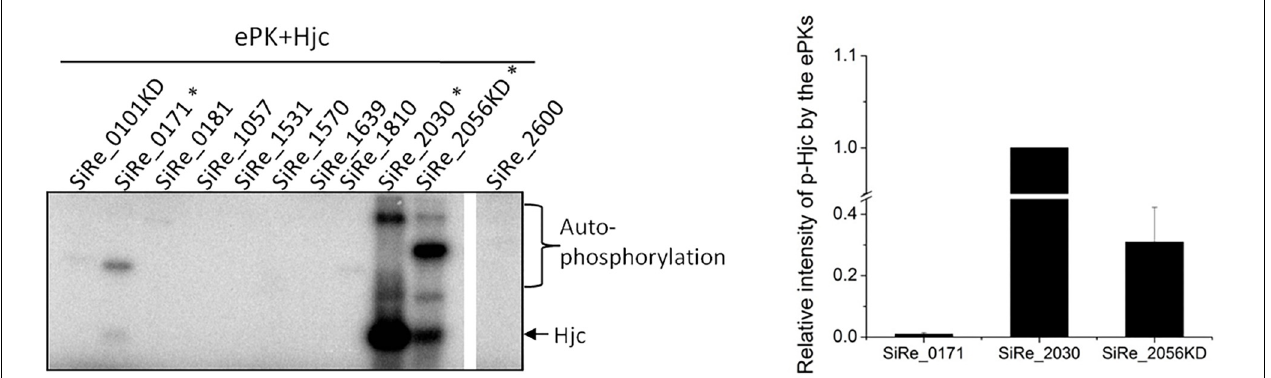
FIGURE 1 | Hjc is phosphorylated by three eukaryotic-like protein kinases (ePKs) SiRe_0171, SiRe_2030, and SiRe_2056KD from S. islandicus in vitro . Each ePK (2 µ M) was incubated with 5 µ M Hjc in the reaction mixture containing [ γ − 32 P]ATP at 65 ◦ C for 30 min (see the Materials and Methods). After reaction, the samples were analyzed by 15% SDS-PAGE. The experiments were performed for at least three times for each enzyme. Left panel, a representative image (15% gel) showing the activities of the ePKs autophosphorylation and phosphorylation on Hjc. The three ePKs that are able to phosphorylate Hjc are labeled with asterisks. Right panel, quantification of the phosphorylation activity of SiRe_0171, SiRe_2030, and SiRe_2056KD on Hjc. The vertical axis shows relative signal strength, the ratio of phosphorylated Hjc by each ePK divided by that by SiRe_2030. Standard deviation is indicated with error bars.